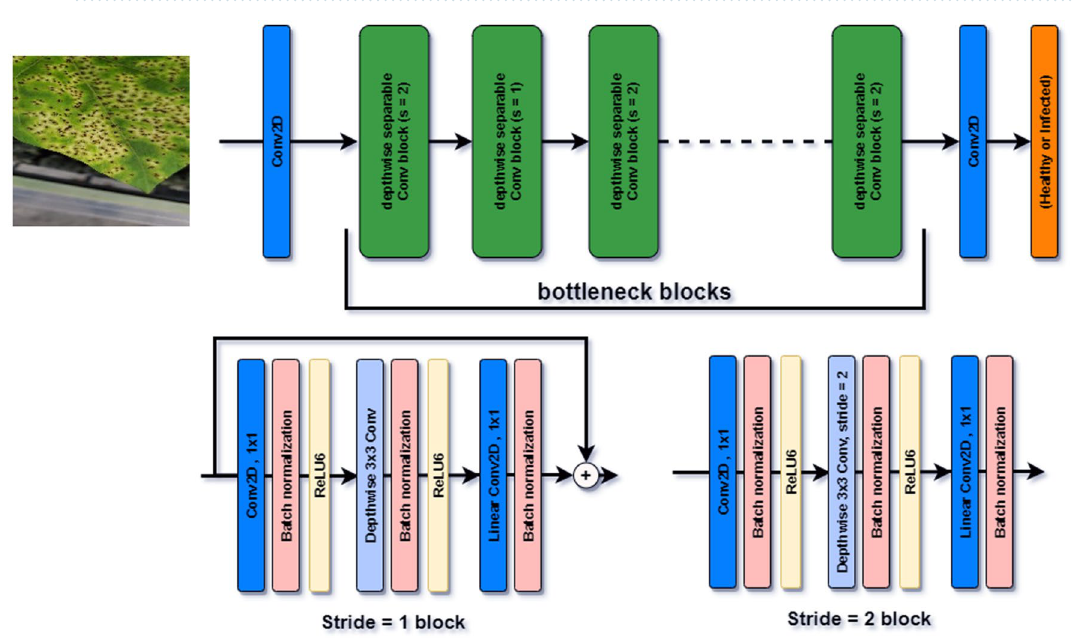
Figure 8. The architecture of the MobileNetV2 with a sample input image and 19 residual bottleneck